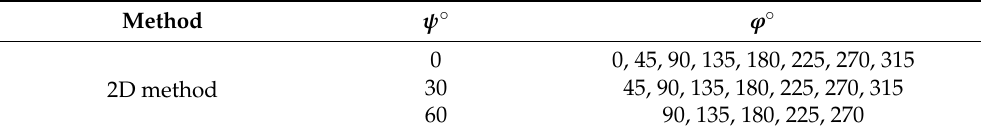
Table 1. Measuring conditions for 2D